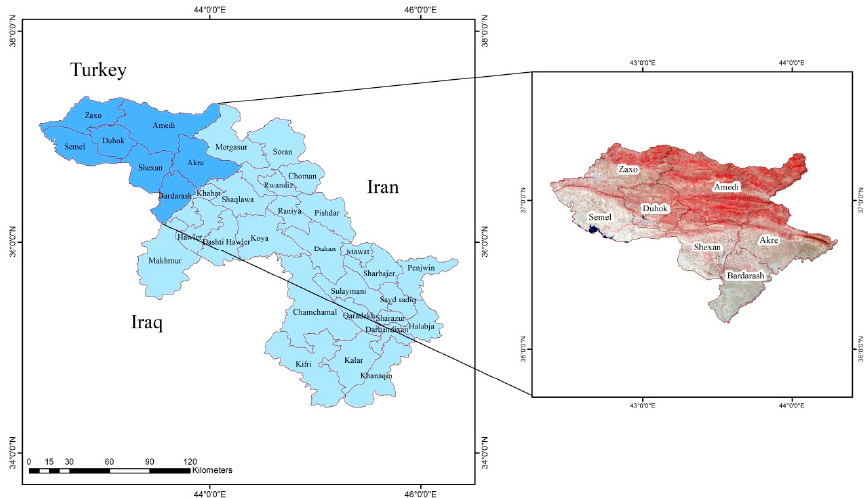
Figure 1. An illustration of the location of the study area. Light blue area is the Kurdistan Region and blue is study area.